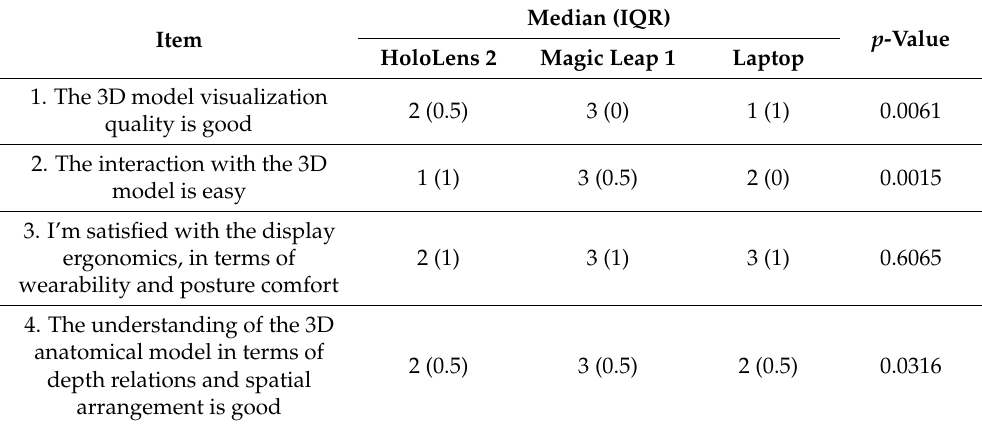
Table 4. Questionnaire results about the comparison between different displays (vote from 1 = the lowest to 3 = the highest in terms of agreement). The central tendency of responses is presented by the median, with the dispersion presented by the interquartile range